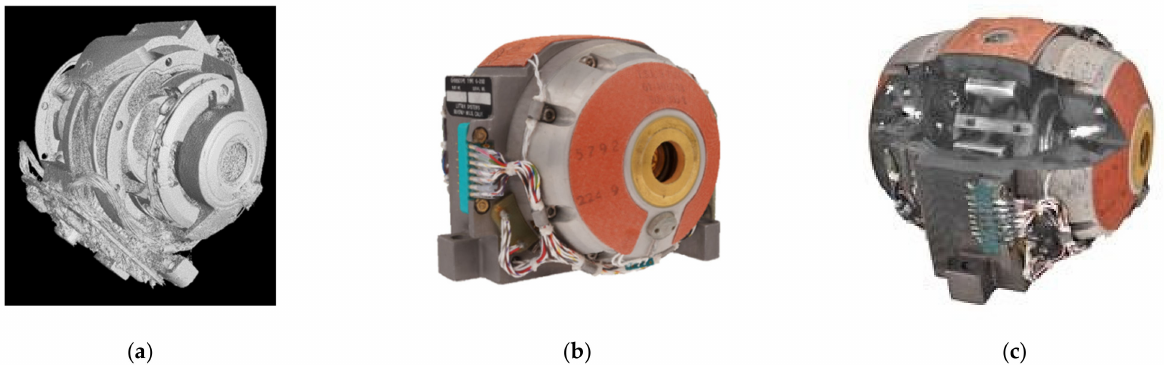
Figure 28. The 3D digital twin of the DM-LN3-G200 gyro: ( a ) iso-surface of a denoised FBP CT scan; ( b ) meshed point cloud of CV/photogrammetry; and ( c ) split view of the CT/CV integrated